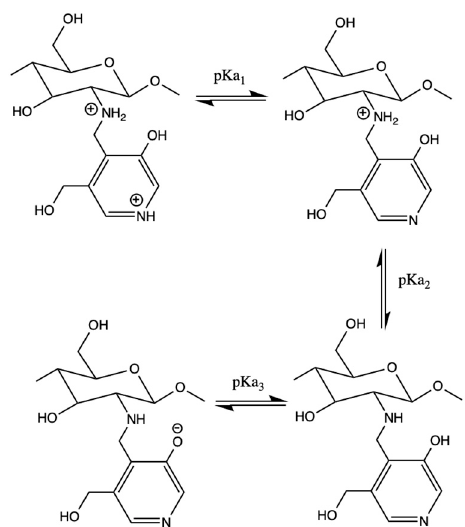
Figure 3. Ionization scheme of Pyr-CS units.